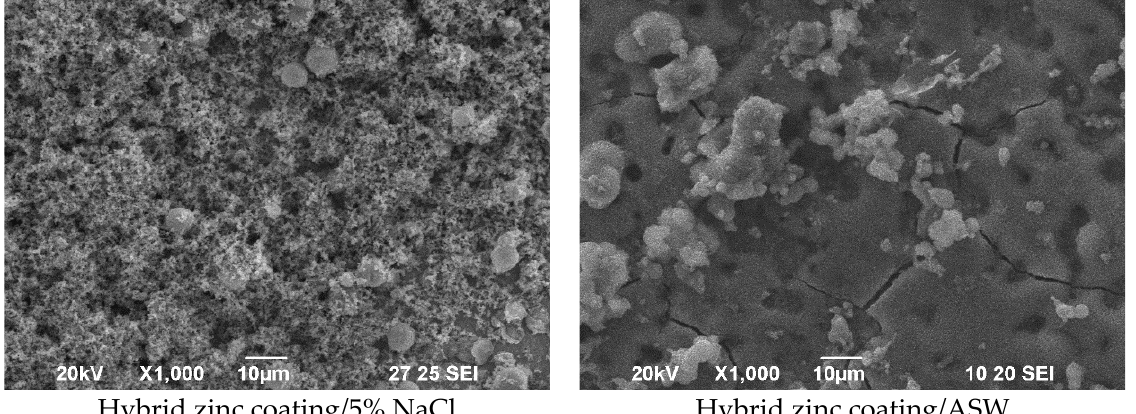
Figure 7. SEM images of hybrid zinc coatings after immersion in the corrosive media.